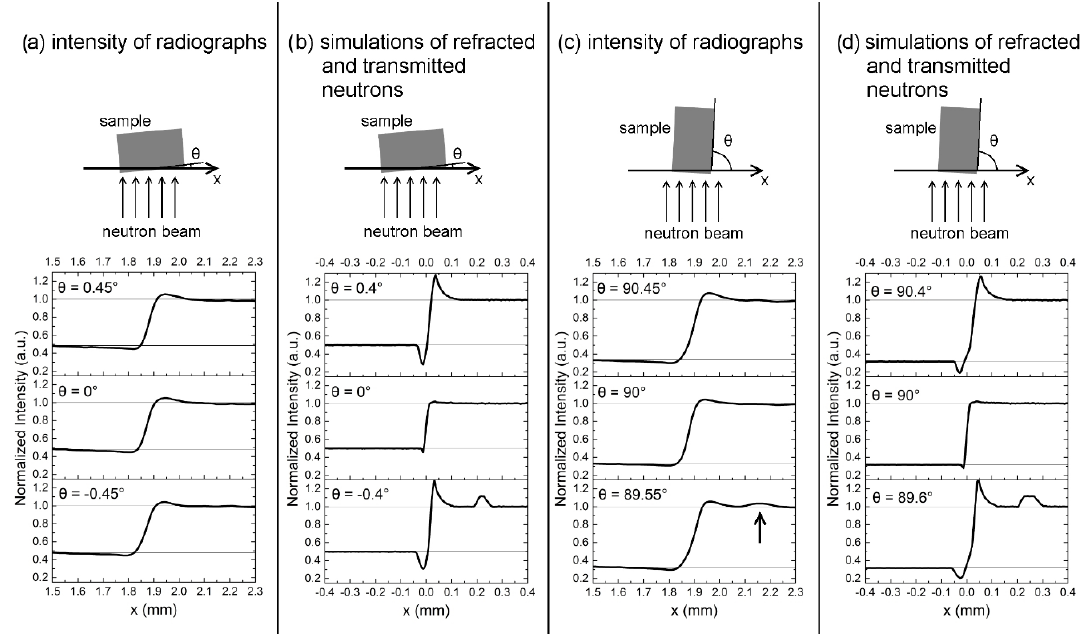
Figure 5. Intensity curves near a sample edge as a function of rotation angle θ. The images on top show the top view of the rotation system and the sample with a cross section of 6 x 10 mm². ( a ) Measured radiograph of hydrogenous steel sample with milled surfaces aligned in parallel direction of the incoming beam. ( b ) Simulation of transmitted and refracted neutrons on a perfectly smooth surface of a simulated supermartensitic steel without additional hydrogen. ( c ) Measured radiograph of hydrogenous steel sample with ground surfaces aligned in direction of the incoming beam. The arrow in θ = 89.55° points to a second intensity maximum. ( d ) Corresponding simulation of transmitted and refracted neutrons on a perfectly smooth surface.